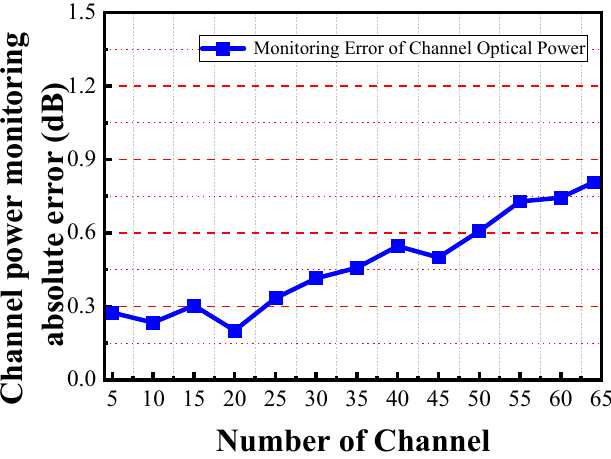
Figure 6. The power monitoring error with different channel numbers.